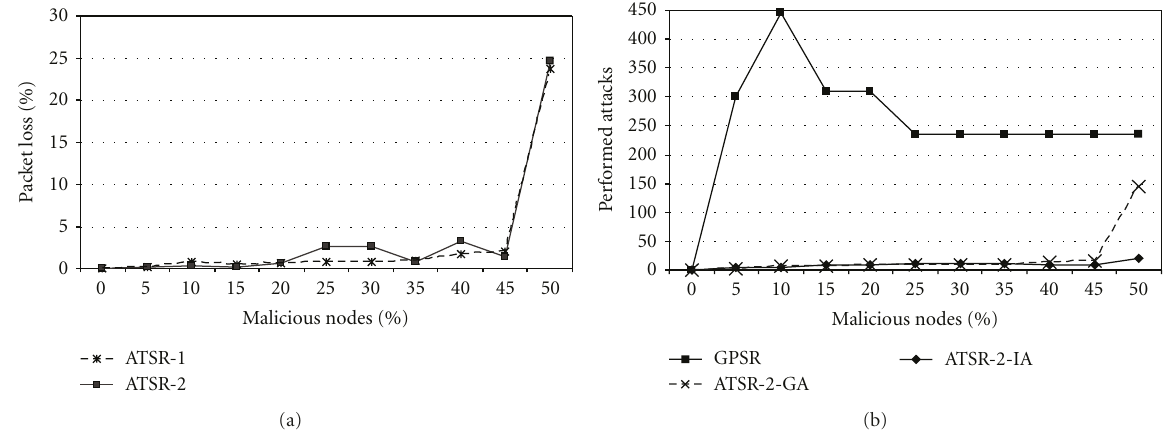
Figure 5: Performance results in the presence of grey-hole (a) and integrity (b) attackers.